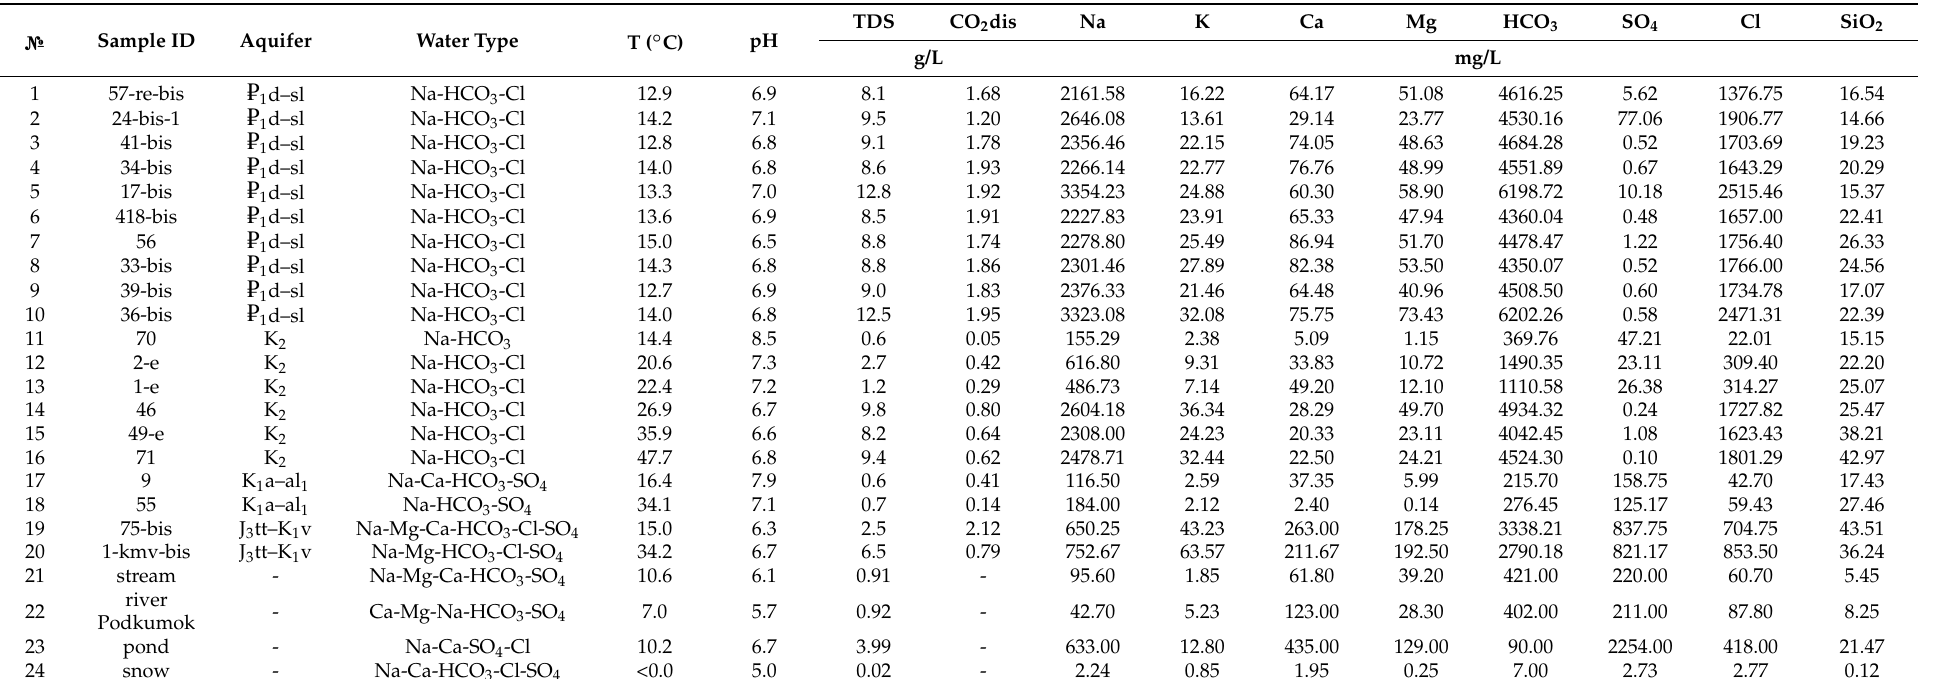
Table 2. Chemical composition of natural mineral water of the Essentuki field.